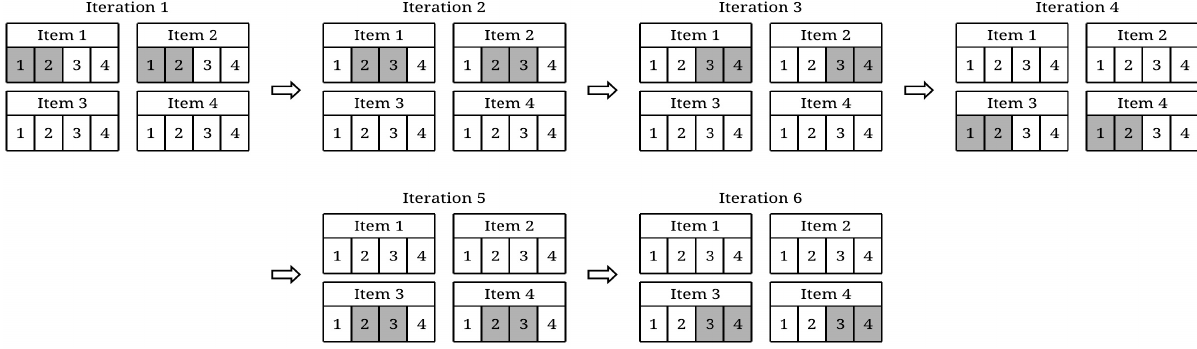
Figure 2. Example – fix-and-optimize heuristic with item-period oriented decomposition